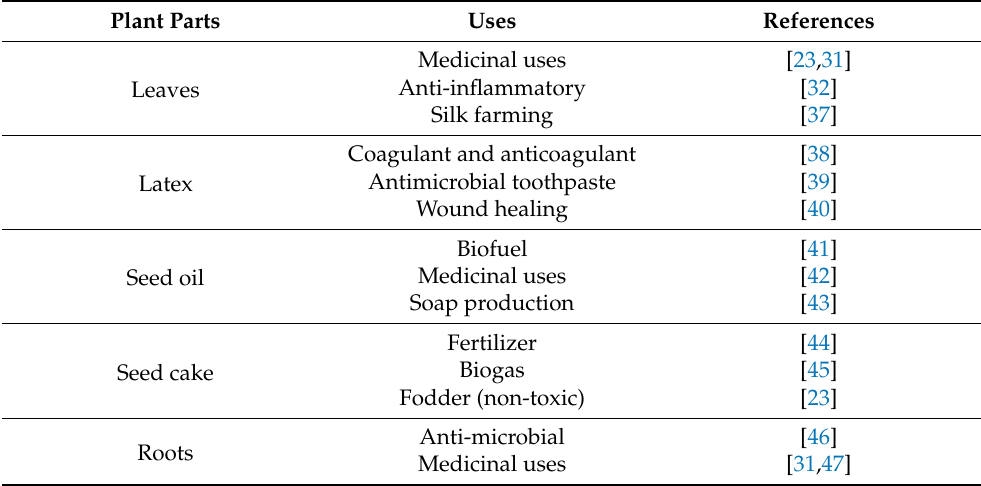
Table 1. Table showing the exploitation of J.